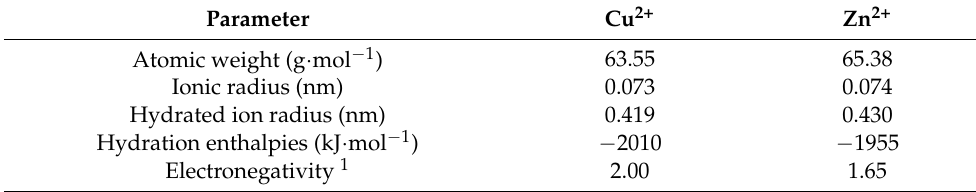
Table 6. Basic characteristics of Cu and Zn ions